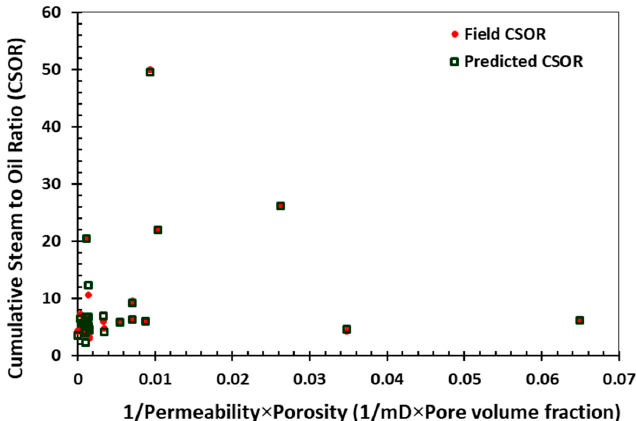
Figure 7. CSOR vs. oil content for the database analyzed.